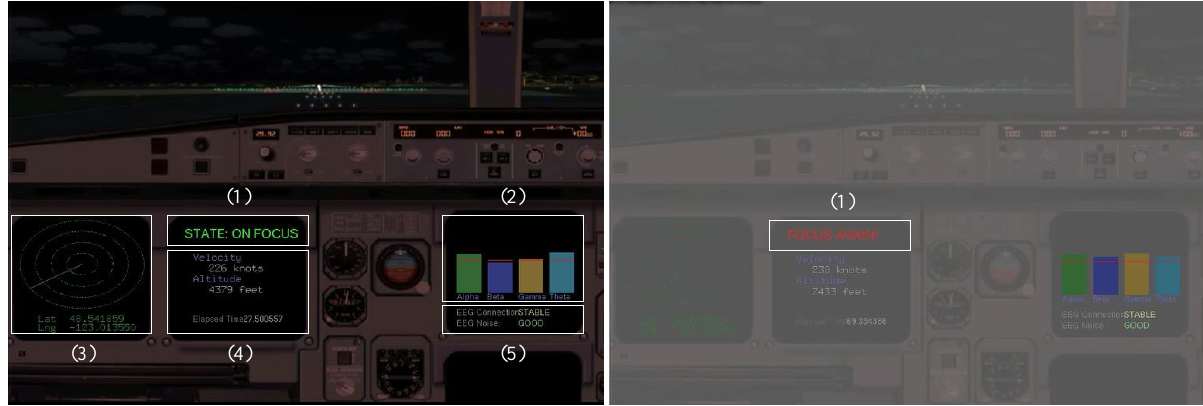
Figure 8. Snapshots of graphical user interface (GUI) in the proposed brain computer interface (BCI)-based attention recovery system during attention state ( left ) and inattention state ( right